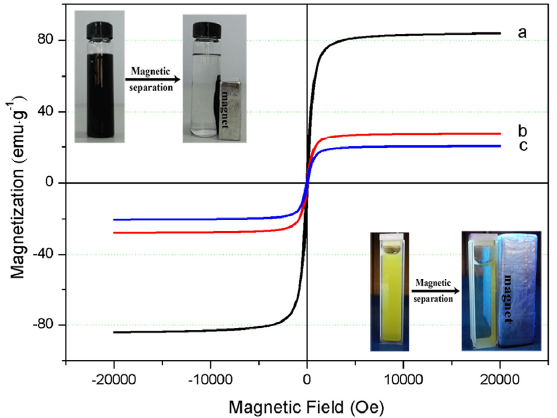
Figure 3. The magnetic hysteresis loops of pure Fe 3 O 4 ( a ); Fe 3 O 4 @SiO 2 ( b ); and Fe 3 O 4 @SiO 2 @GdVO 4 :Dy 3+ ( c ).